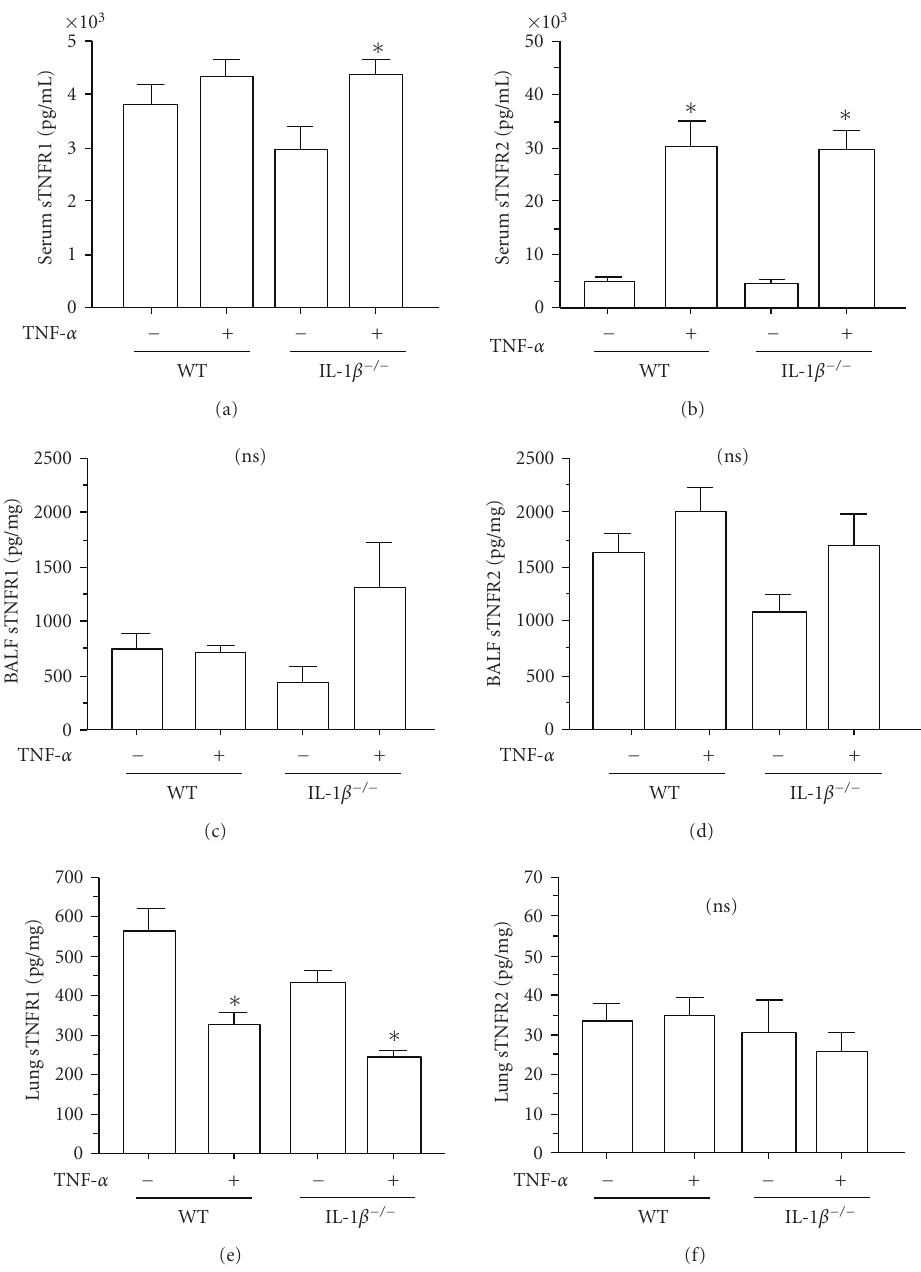
Figure 2: Detection of soluble receptors in WT and IL-1 β KO mice . WT or IL-1 β KO mice were OP instilled with either saline (50 μ L) or TNF- α (5 μ g/50 μ L/mouse). After 6 hours, serum, BALF, and lung homogenate were isolated and analyzed for ((a), (c), and (e)) TNFR1 or ((b), (d), and (f)) TNFR2 by ELISA, and for lavage and lung, normalized to protein in samples measured by BCA. Results are mean ± SEM, ( n = 8–15 mice per group). ∗ represents P ≤ . 05 saline versus TNF- α -treatment of single strain or (brackets) for saline or cytokine-treated comparisons between